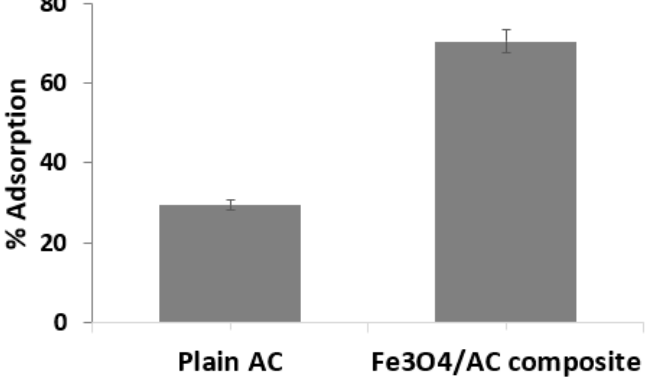
Figure 1. Percentage of As (III) adsorption by plain AC (activated carbon) and Fe 2 O 3 / AC composite with error bars.